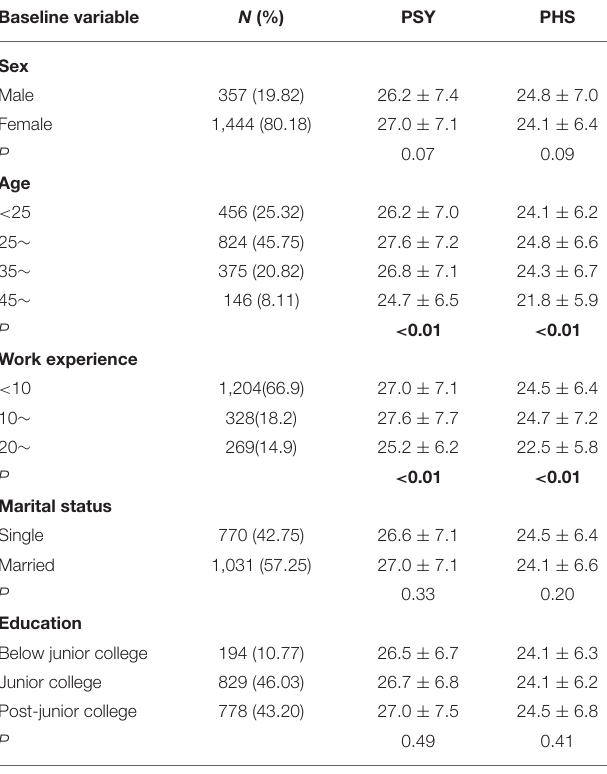
TABLE 1 | The level of individual stress response of medical staff. Baseline